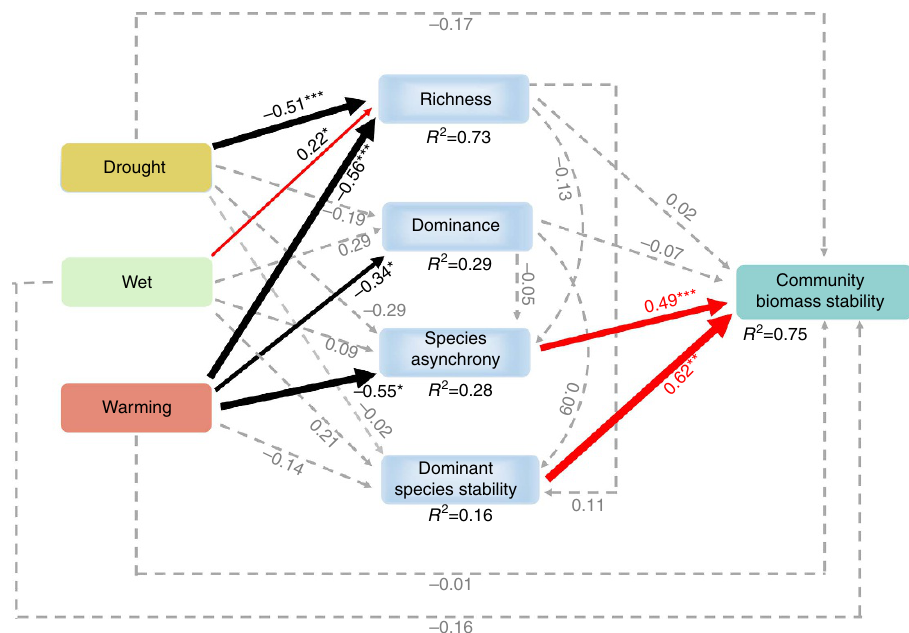
Figure 4 | A structural equation model of treatment effects on biomass temporal stability. The structural equation model considered all plausible pathways through which experimental treatments influence community biomass temporal stability. Red and black arrows represent significant positive and negative pathways, respectively, and grey dashed arrows indicate nonsignificant pathways. Bold numbers indicate the standard path coefficients. Arrow width is proportional to the strength of the relationship. R 2 represent the proportion of variance explained for each dependent variable in the model. * P o 0.05, ** P o 0.01, *** P o 0.001; w 2 ¼ 7.27, P ¼ 0.03; root mean square error of approximation (RMSEA) ¼ 0.30, P ¼ 0.03; Akaike information